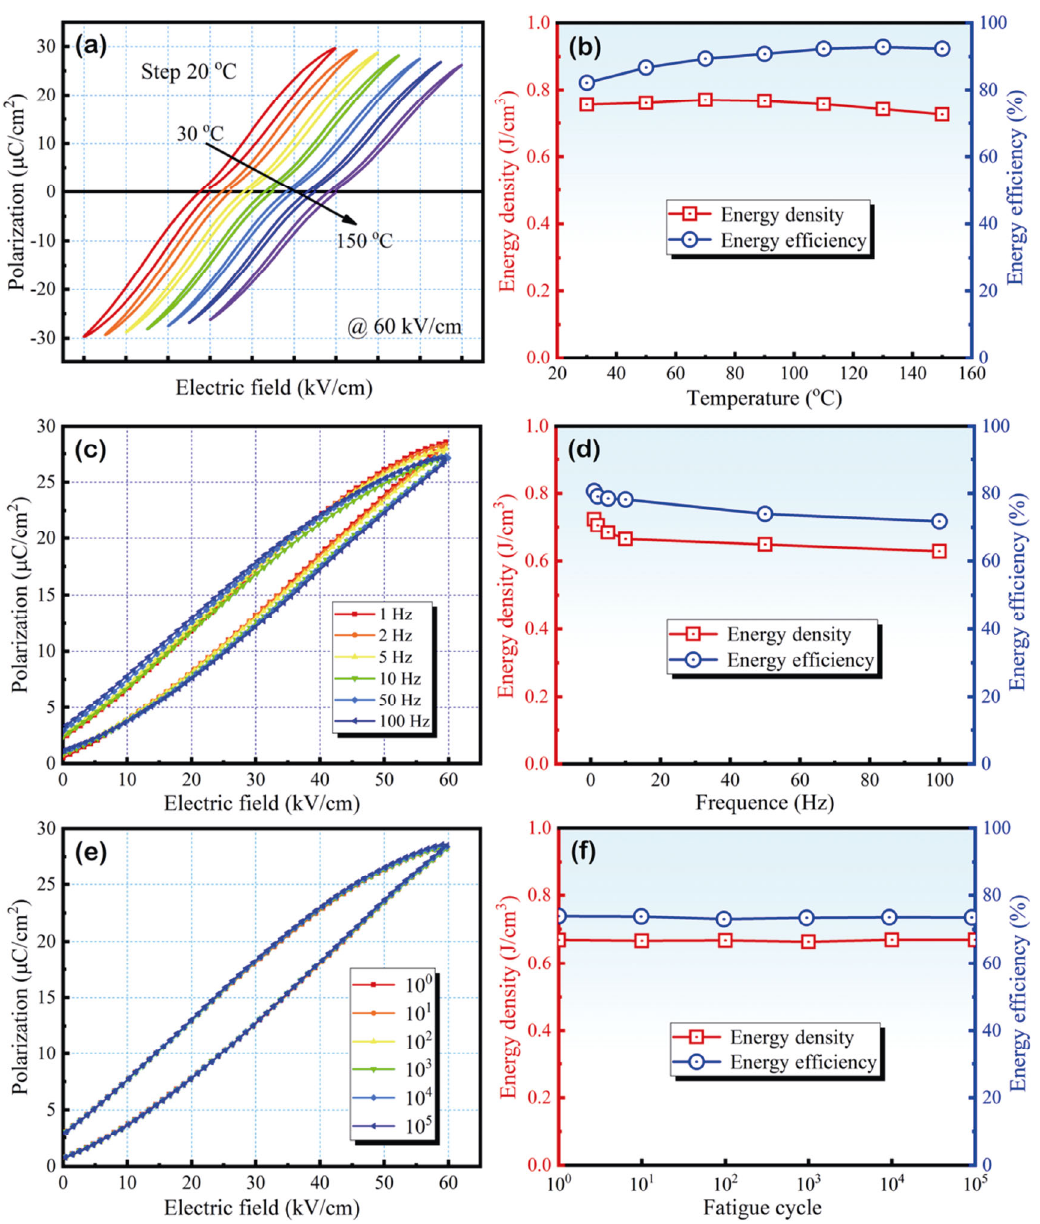
Fig. 7 P – E loops as a function of (a) temperature, (c) frequency, and (e) cycle number for BNS 0.245 − 1.5 x (cid:0) 0.5 x B 0.325+ x T ceramics with x = 0.06. W rec and as functions of (b) temperature, (d) frequency, and (f) cycle number for BNS 0.245 − 1.5 x (cid:0) 0.5 x B 0.325+ x T ceramics with x =